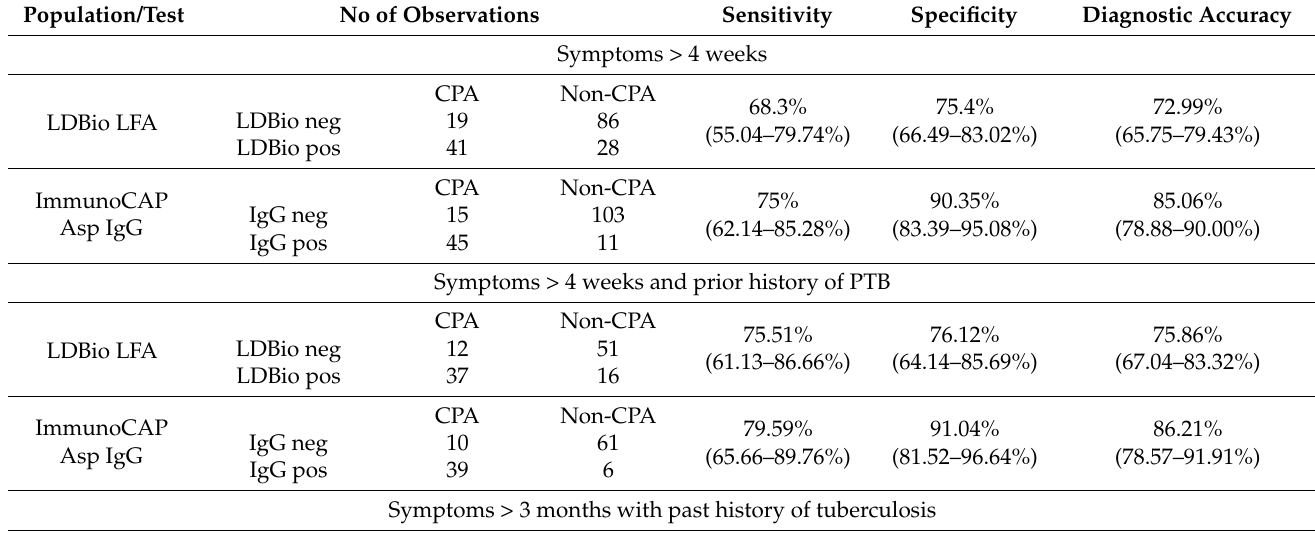
Table 5. Sensitivity & specificity of LDBio LFA kit & ImmunoCAP Asp IgG (cut off >40